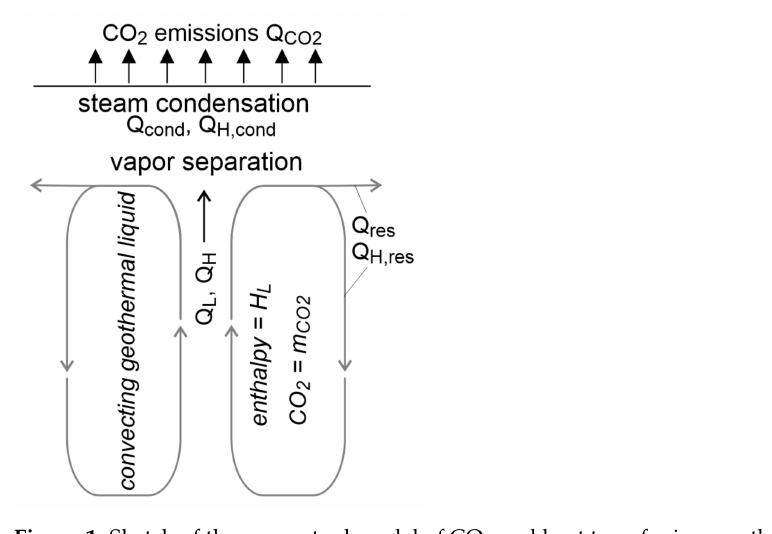
Figure 1. Sketch of the conceptual model of CO 2 and heat transfer in a geothermal